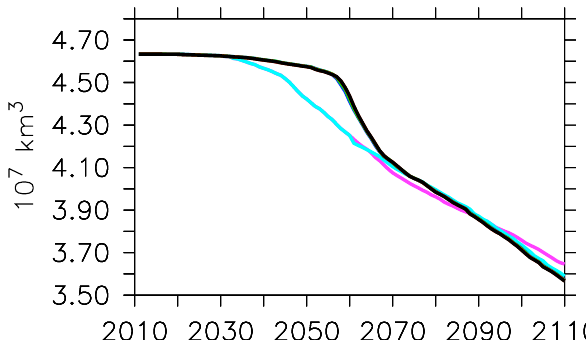
Fig. 10. Temporal evolution of the simulated volume of surface (0– 100m) waters with arragonate saturation state (cid:127) Ar > 1. The black line refers to the unfertilized control experiments, the OIF experi- ments are referred to by the same color code as in Fig.